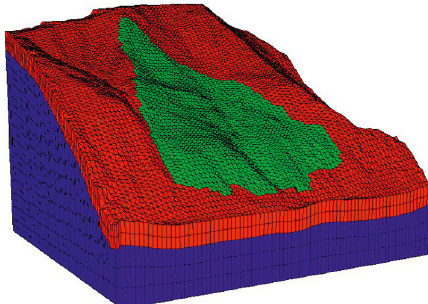
Figure 16: 3D finite element model for the Zhenggang landslide.